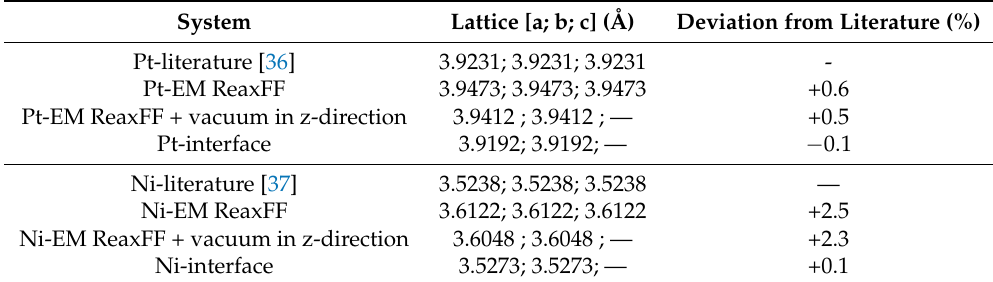
Table A3. Lattice constant for Pt and